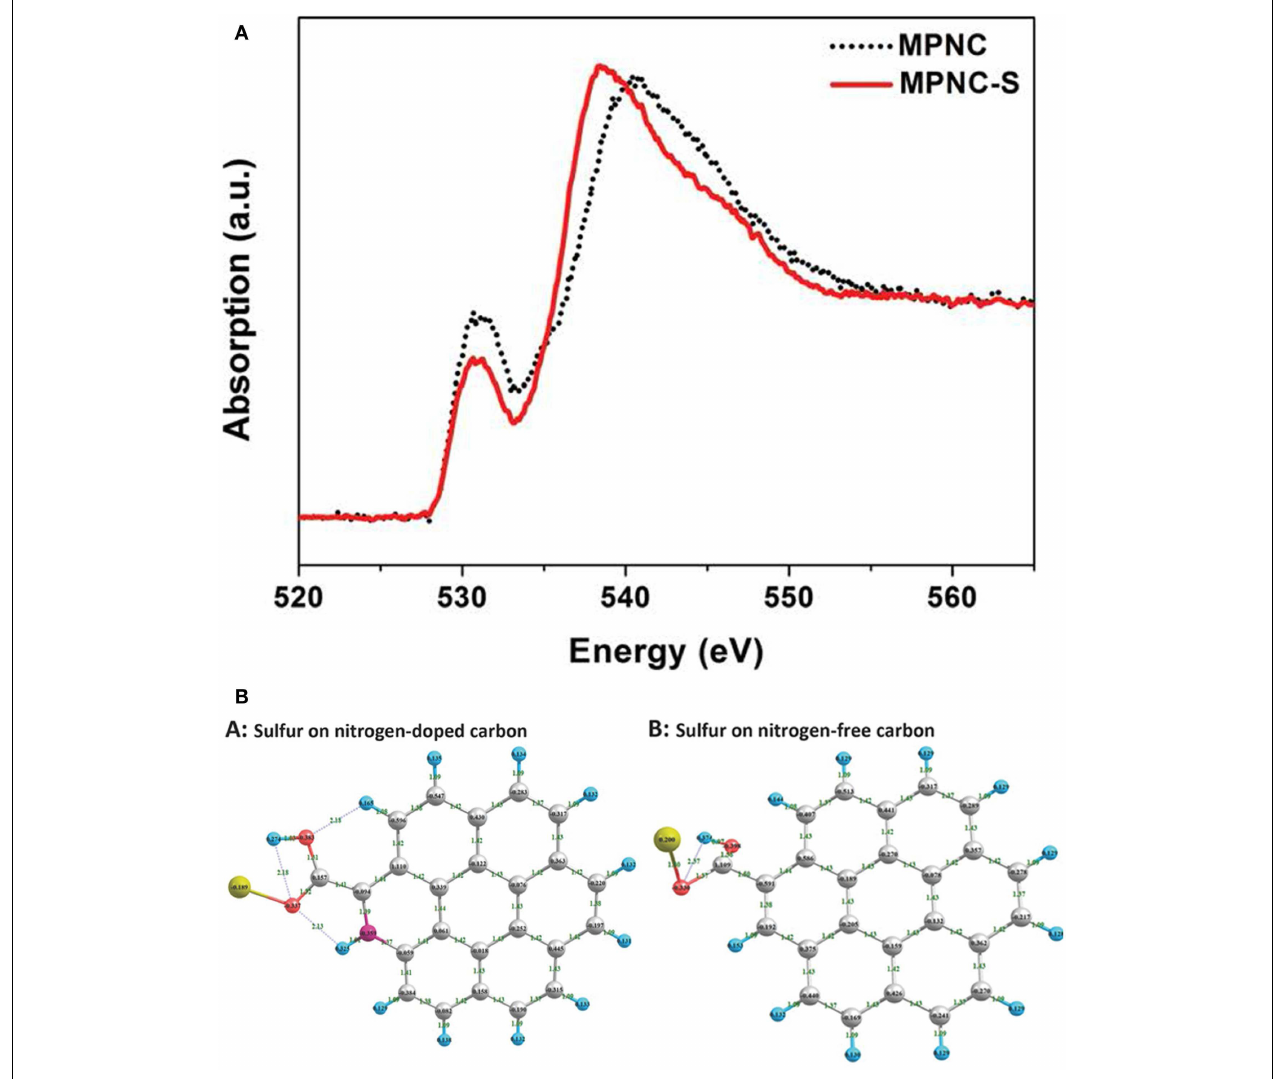
FIGURE 3 | (A) Oxygen K-edge XANES spectra and (B) molecule simulation of mesoporous nitrogen-doped carbon (MPNC) and MPNC-sulfur nanocomposites (Song et al., 2014).